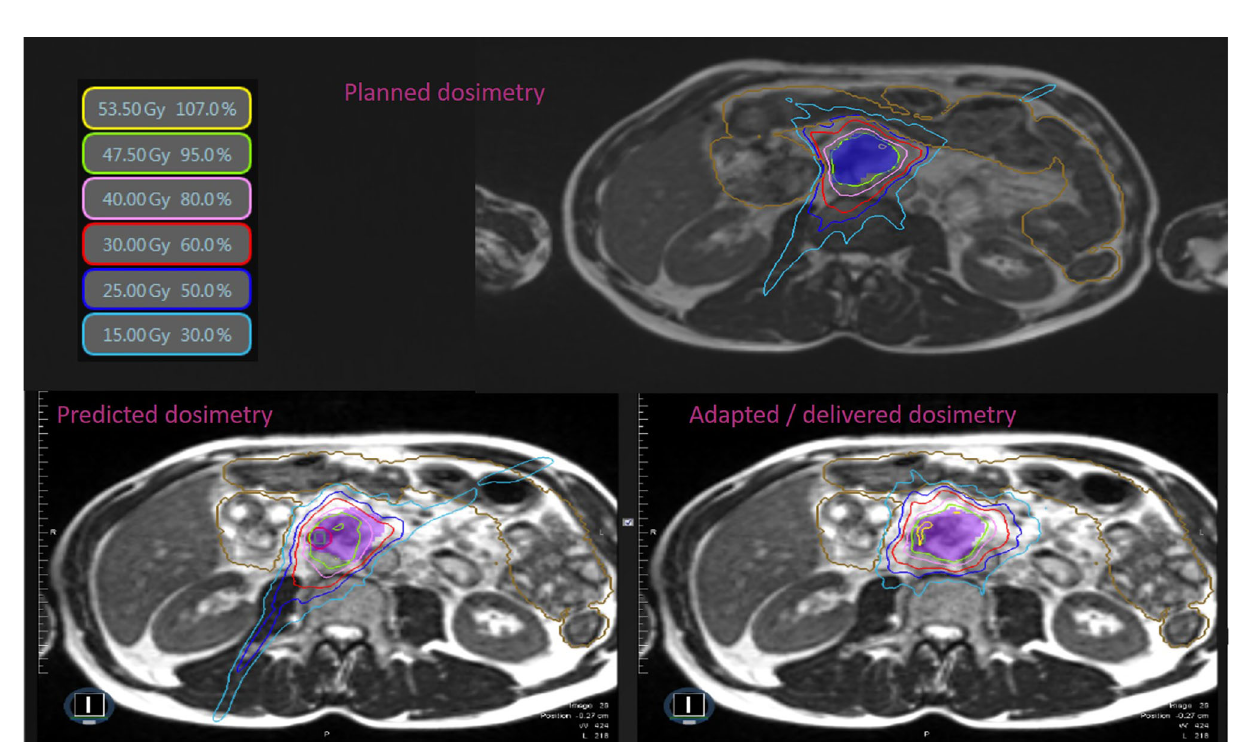
FIGURE 1 | Typical SMART dosimetry showing planned, predicted, and adapted/delivered dosimetry. Comparison of dose distribution between planned, predicted, and adapted/delivered dosimetry on MR 0.35-T TRUFISP images for a prescription of 50 Gy in 5 fractions in LAPC. Isodose line 53.5 Gy in yellow, 47.5 Gy in green, 40 Gy in rose, 30 Gy in red, 25 Gy in blue, and 15 Gy in cyan. Small intestine in brown. LAPC, locally advanced pancreatic cancer; SMART, stereotactic MR-guided adaptive